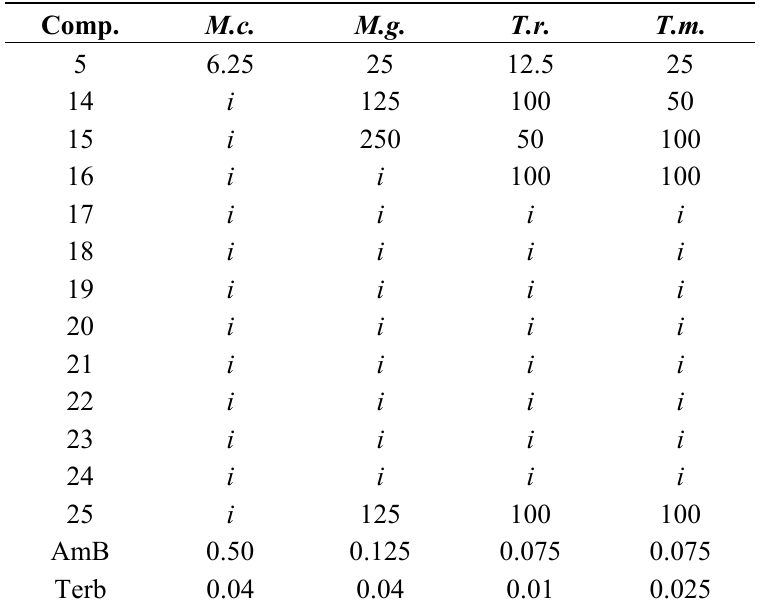
Table 2. Antifungal activity (MIC values,  g/mL ) of phthalazinones 14 – 25 against dermatophytes.